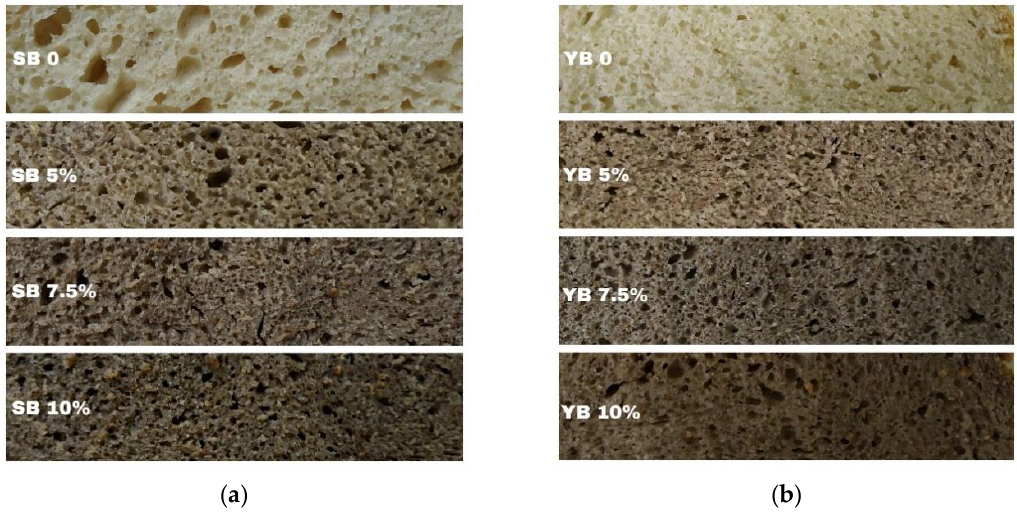
Figure 2. Pictures of the crumb of sourdough bread ( a ) and baker’s yeast bread ( b ) produced with increasing flaxseed cake percentage (0, 5, 7.5, 10%). Table 5. Color coordinates L*a*b* values of the cooked bread samples. Data presented are the mean of three replicates. Data reported in italics were already published in Sanmartin et al., 2020 [39].